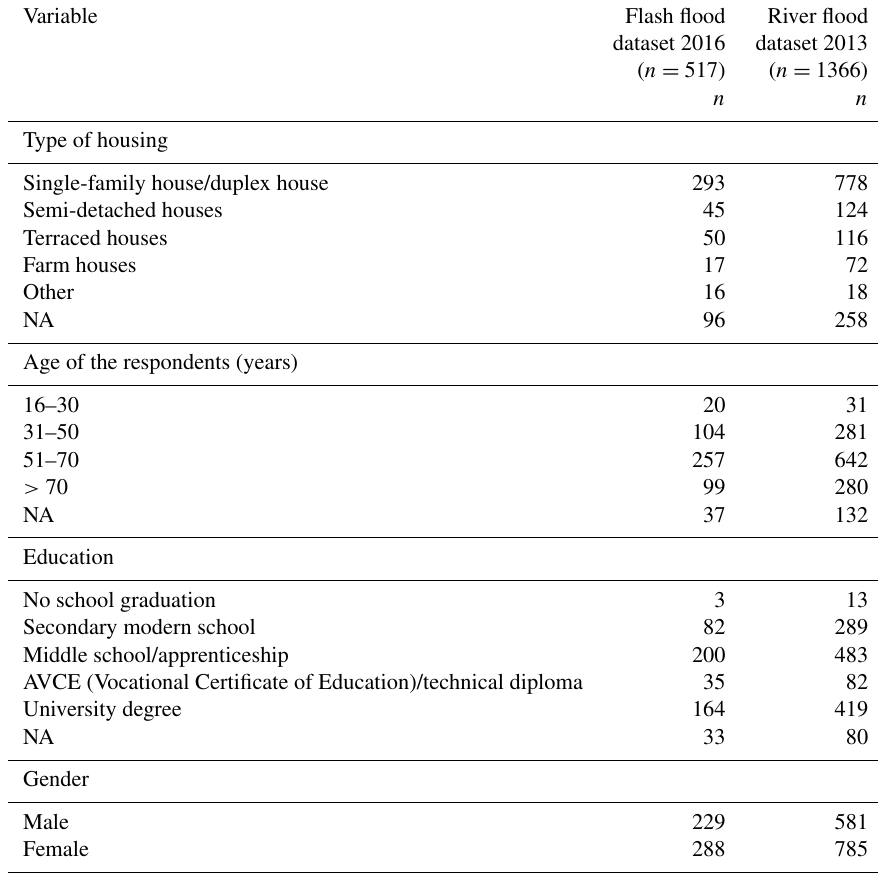
Table A1. Information about the samples and